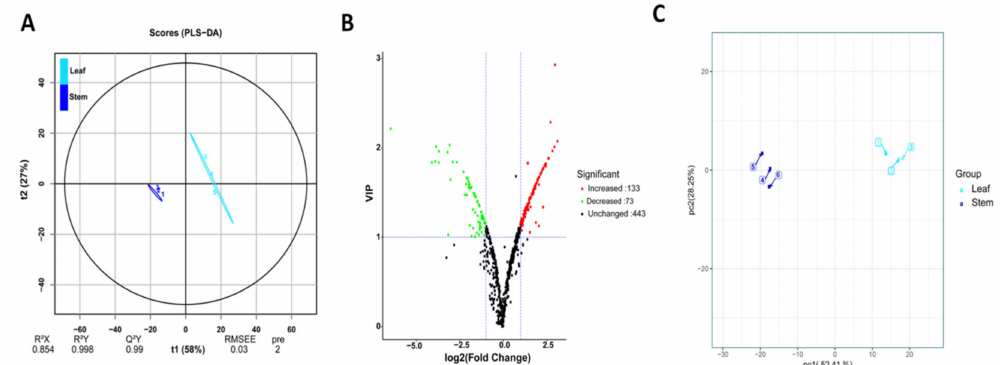
Figure 2. Identification of metabolites di ff erentially accumulated in stems and leaves of D. nobile. ( A ) The partial least squares-discriminant analysis (PLS-DA) score plot. ( B ) Volcano plot showing the increased and decreased metabolites between leaves and stems. ( C ) Principal component analysis score plot based on the 206 di ff erential